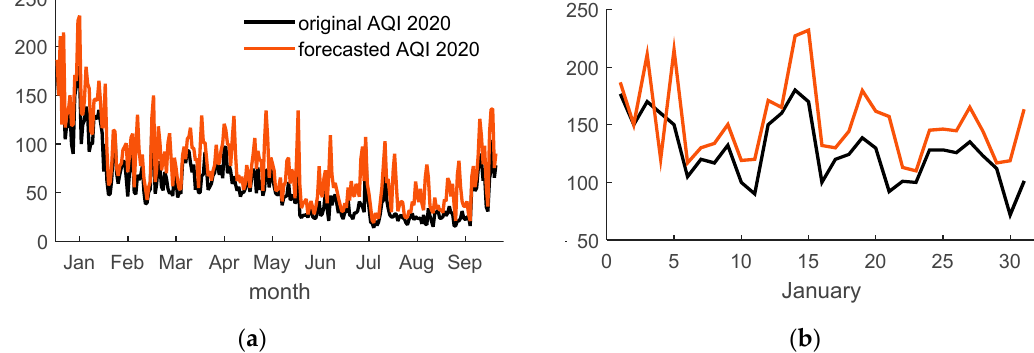
Figure 8. ( a ) Original and forecasted AQI using hybrid EMD-SARIMA model ( b ) results shown for January only. Table 7. Common metrics result for model SARIMA (0, 1, 1) × (0, 1, 1) 12. Metric